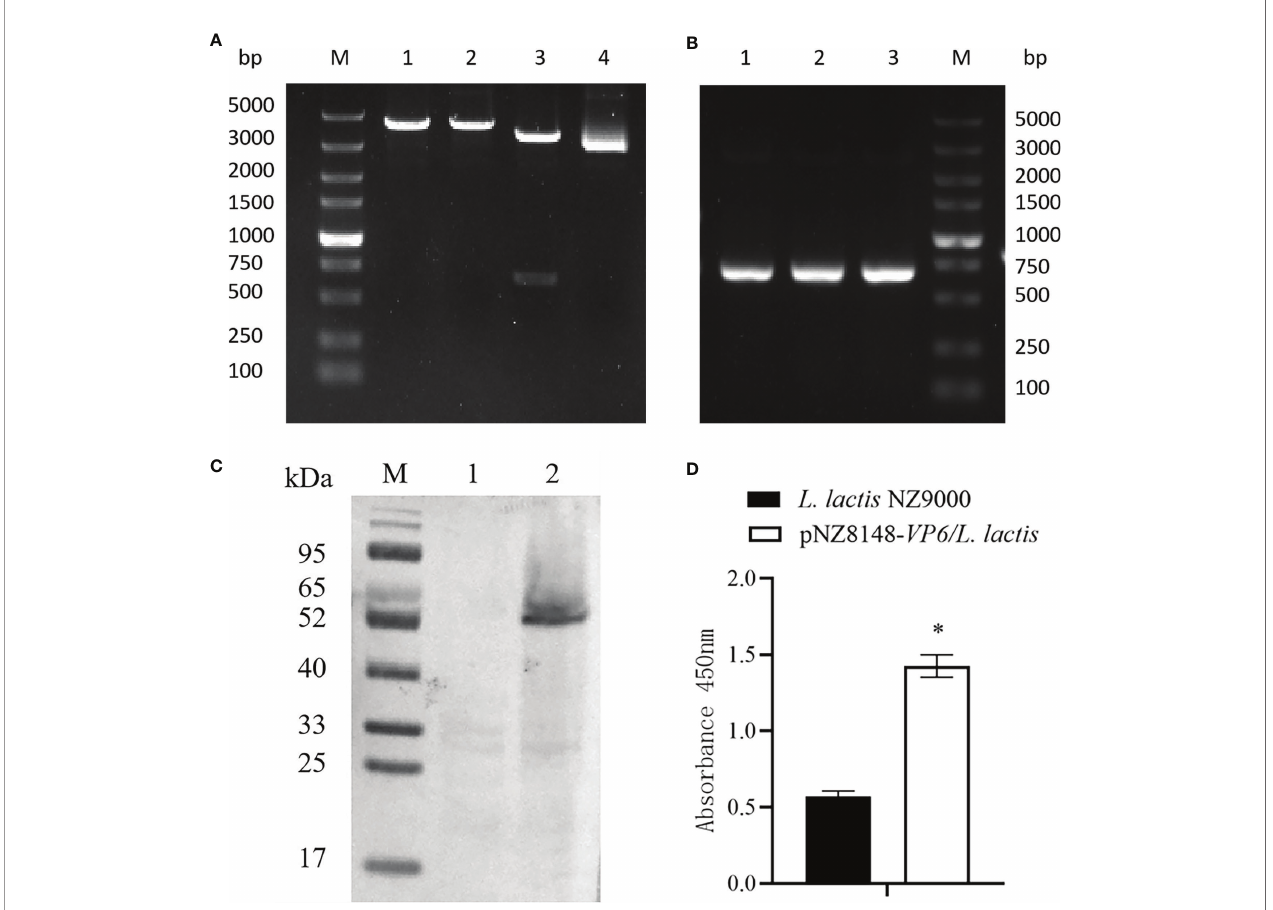
FIGURE 2 | Identi fi cation of the recombinant strain pNZ8148- VP6 / L. lactis . (A) Identi fi cation by enzyme digestion. M: DNA maker DL5000; Lane 1: Nco I digestion; Lane 2: Xba I digestion; Lane 3: double digestion; Lane 4: pNZ8148- VP6 plasmid. (B) Identi fi cation of recombinant plasmids pNZ8148- VP6 by PCR. Lane M: DNA marker DL5000, Lanes 1 – 3: L. lactis pNZ8148- VP6 . (C) Western blot analysis of pNZ8148- VP6 fusion protein expression, M: Low molecular weight protein maker. Lane 1: negative control L. lactis NZ9000. Lane 2: L. lactis pNZ8148- VP6 . (D) Indirect ELISA analysis of pNZ8148- VP6 fusion protein expression. *p <